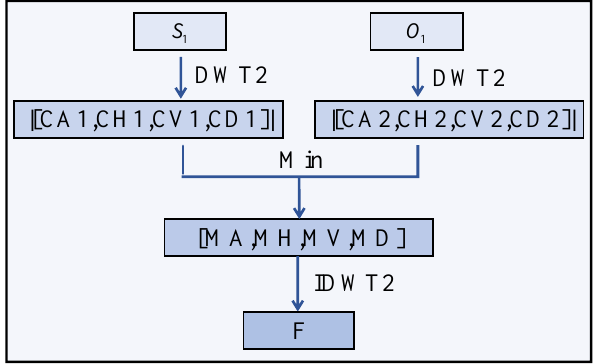
Figure 14. Flowchart of the image fusion.